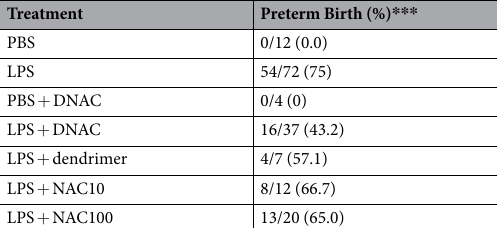
Table 1. Preterm birth rate. *** Chi Square test, p <